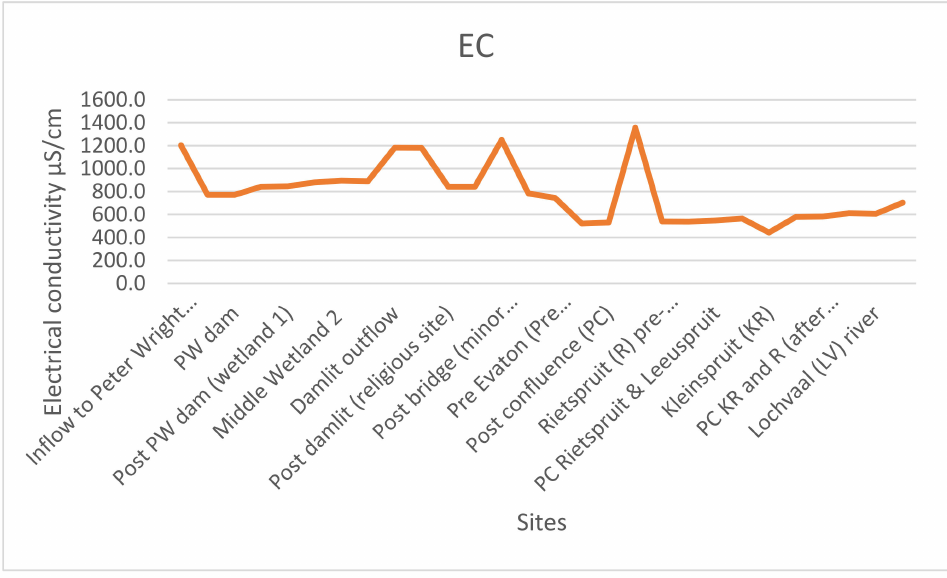
Figure 3. EC reading at the sampled